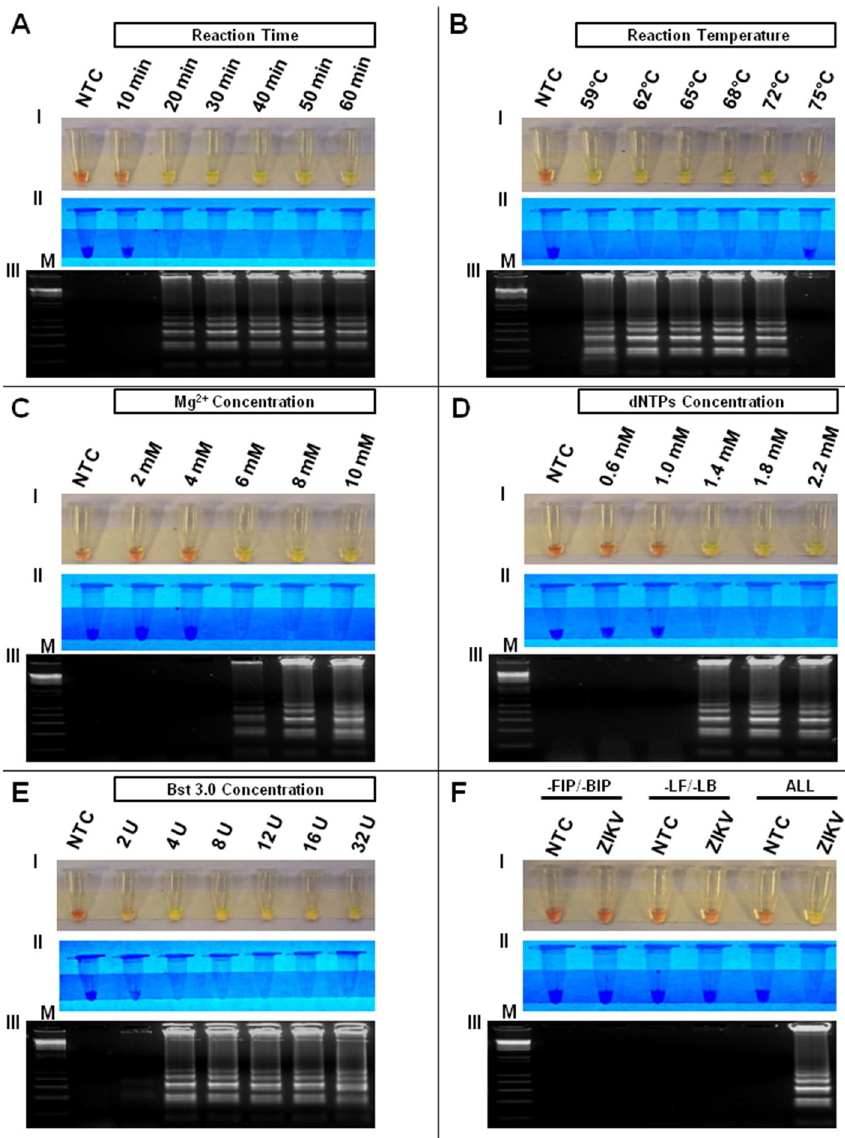
Figure 1. Optimization of reagent concentrations and conditions of the ZIKV RT-LAMP assay. All reagent concentrations as well as all RT-LAMP assay conditions were optimized and established. The reactions were performed under incubation time ranging from 10 to 60 min ( A ) and temperatures ranging from 59 to 75 °C ( B ). The reagents were optimized for optimal concentrations of Mg 2+ (ranging from 2 to 10 mM) ( C ), dNTPs (ranging from 0.6 to 2.2 mM) ( D ) and Bst 3.0 DNA polymerase (ranging from 2 to 32 U) ( E ). In addition, all primers, including external primers (F3 and B3), internal (FIP and BIP) and loop (LF and LB) were required to perform the RT-LAMP assay ( F ). The RT-LAMP results were observed by visual color change of the products in the reaction tube and by gel electrophoresis. Amplification products were observed by naked eye natural light (A-FI) under UV irradiation (A-FII) and agarose gel electrophoresis (A-FIII). Legends: NTC (non-template control): water; M: molecular weight marker. Orange color: negative reaction for ZIKV; Greenish yellow color: positive reaction for